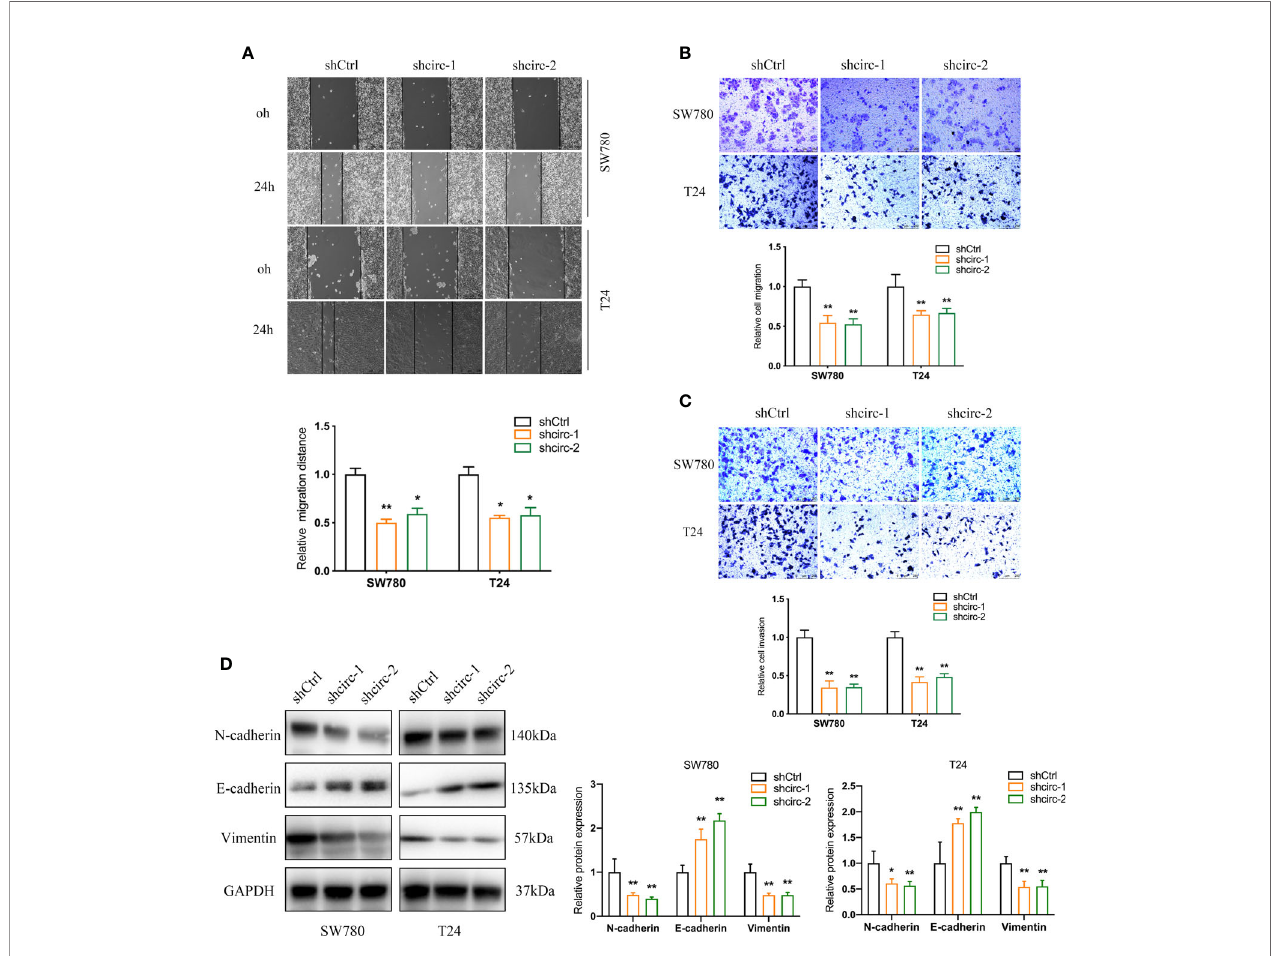
FIGURE 3 | Knockdown of circTAF4B suppressed the migration, invasion and EMT process of BCa cells in vitro . (A, B) Wound healing and Transwell migration tests showed that transfection of shcircTAF4B downregulated the migration of BCa cells. (C) Transwell invasion assays revealed that knockdown of circTAF4B inhibited the invasion of BCa cells. (D) Protein expression levels of EMT markers were detected by western blotting assay. Data represent the mean ± SD of more than three independent experiments. *p < 0.05; **p <